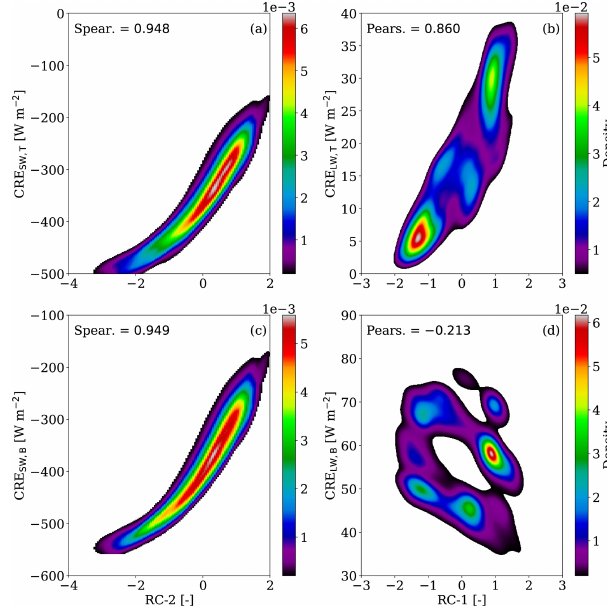
Figure 7. For the reference simulation (ref.), BKD between CRE SW and the second rotational component (RC-2) at (a) TOA and (c) BOA, and between CRE LW and the first rotational component (RC- 1) at (b) TOA and (d) BOA. The corresponding Spearman (Spear.) and Pearson (Pears.) correlations are highlighted for the SW and LW radiation,